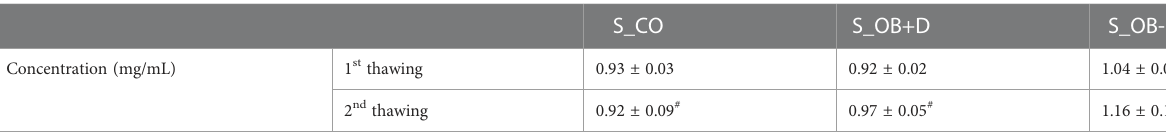
TABLE 1 Protein concentration of 100-fold concentrated JPC